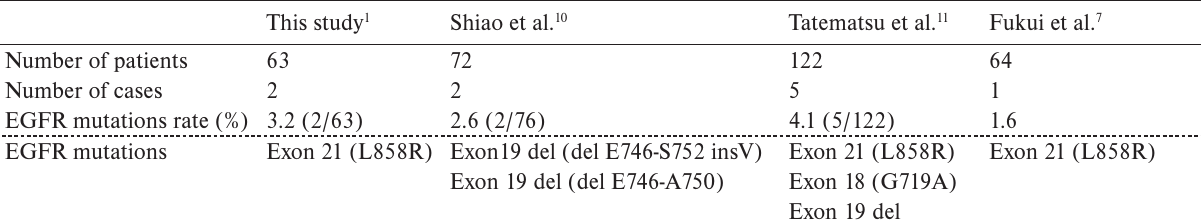
Table 1. Comparisons of SCLC patient profiles with EGFR